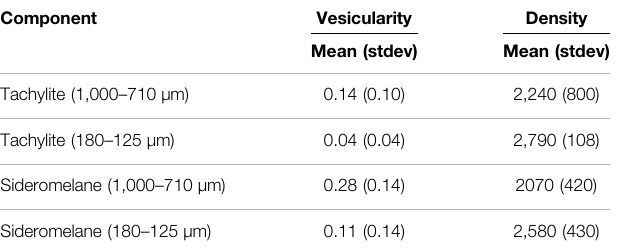
TABLE 1 | Vesicularity and density of juvenile components.